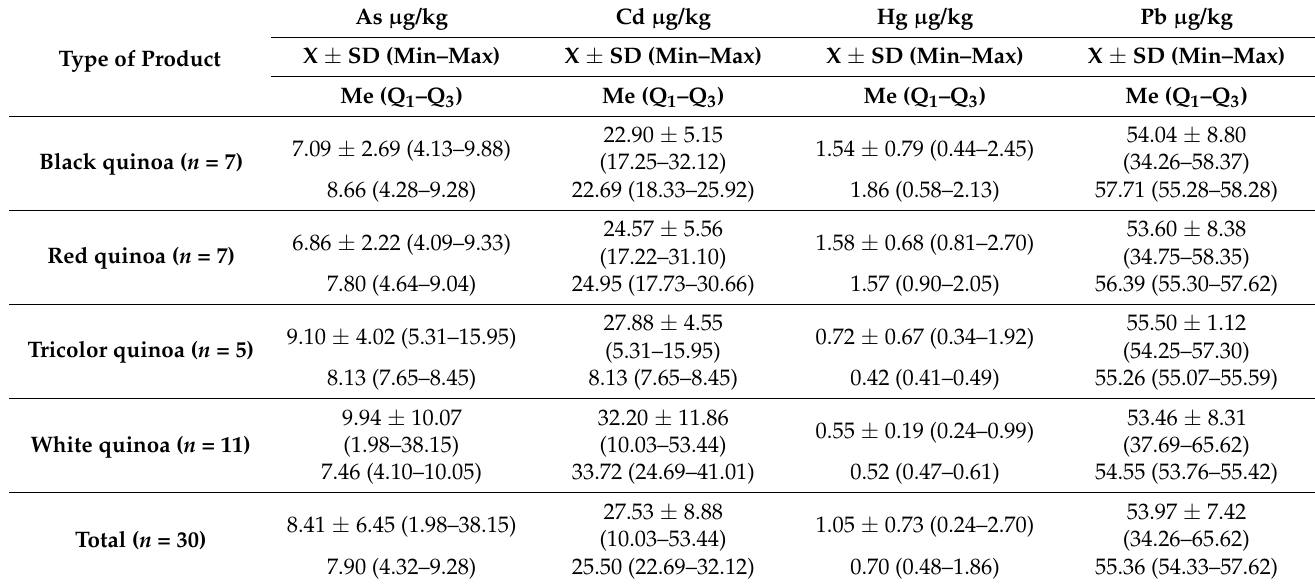
Table 5. The content of the toxic elements in quinoa